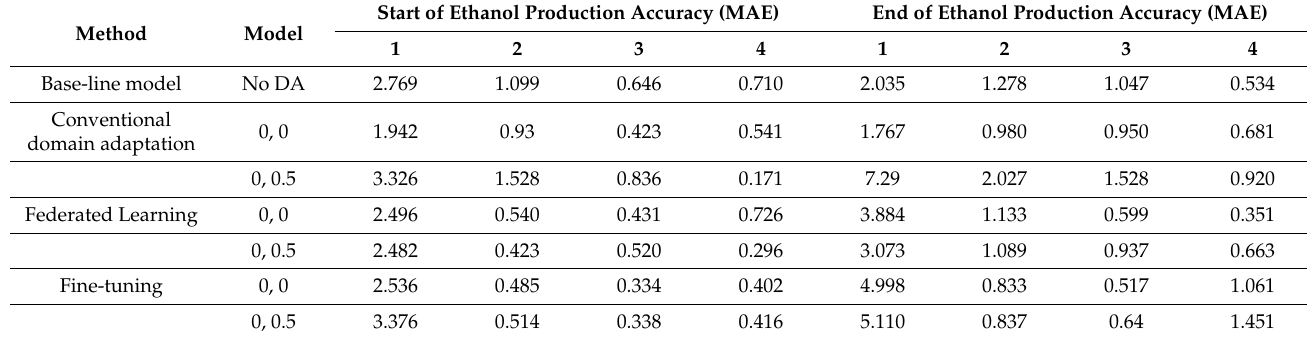
Figure 5e,f display the classification results for the previously discussed federated models fine-tuned on the industrial dataset. While still providing improvements over the No DA base case, achieving higher classification accuracies for 12 out of 16 tasks, their accuracy is reduced over the starting federated learning models. This is most likely due to the fine-tuning method overfitting during training. The reason for this is the large network size required to learn both domains in the starting models. For example, the No DA models had a maximum optimum number of eight neurons in the fully connected layer and four LSTM units to learn only the target domain. However, the federated learning models required a maximum of 128 neurons in the fully connected layer and eight LSTM units to fit to both dataset domains. Therefore, when fine-tuning on the industrial dataset after fitting to both domains, the model begins to overfit, especially when four industrial batches are used in the training set. Table 3. The regression accuracies of each of the models for predicting the time remaining until the start and end of ethanol production, where MAE is the Mean Absolute Error of the prediction. The base-line model was trained using only data from the industrial fermentations. The numbers in the Model column indicate the dropout probability used in each dropout layer. E.g., 0,0 represents 0 dropout probability in both